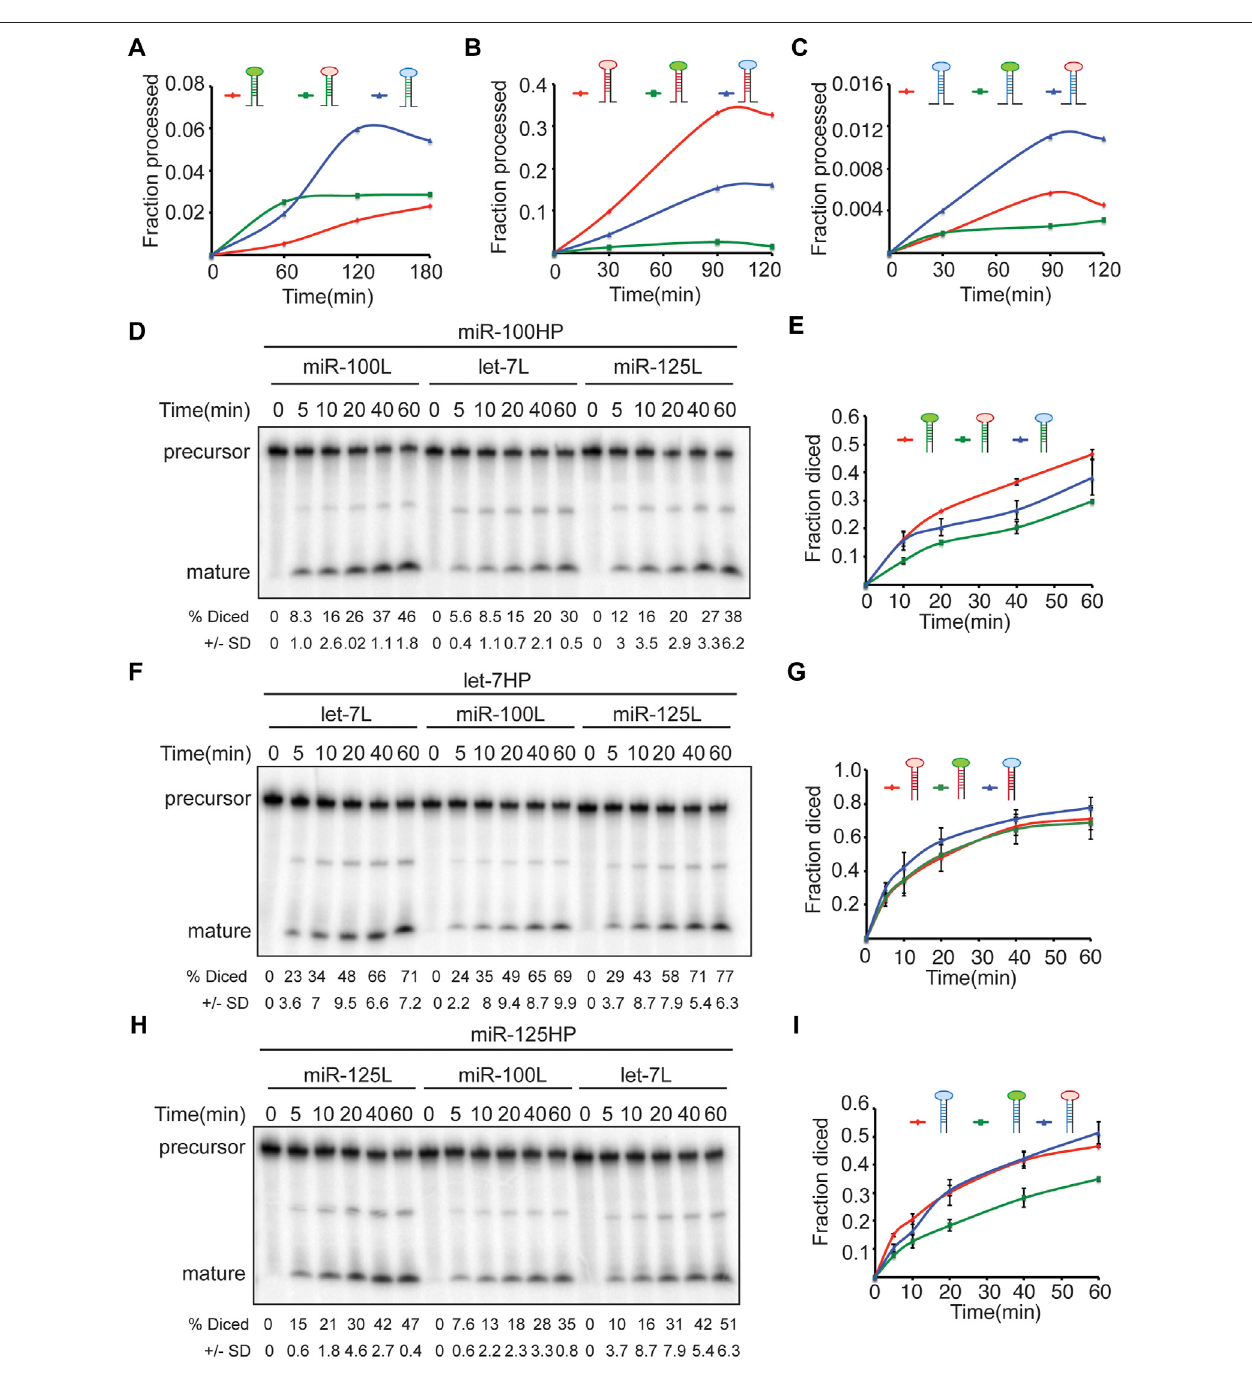
FIGURE 8 | Terminal loops determine the kinetics of Drosha and Dicer processing of let-7-C miRNAs. (A – C) Chimeric and wild type transcripts were subjected to Drosha cleavage, and the fraction of processed pre-miRNA was calculated as the ratio of pre/pre+pri. Line graph depicting kinetics of processing of wild type (red line) and chimeric pri-miR-100 (blue and green) (A) , wild type (red line) and chimeric pri-let-7 (green and blue) (B) , and wild type (red line) and chimeric pri-miR-125 (C) . (D – I) ChimericandwildtypetranscriptsweresubjectedtoDicercleavage,andthefractionofprocessedmiRNAwascalculatedastheratioofpro/pre+pro. (D) Pre-miR- 100 was processed more ef fi ciently than pre-miR-100Hlet-7L or pre-miR100HmiR-125L. Products were resolved by gel electrophoresis on a 10% polyacrylamide gel. (E) Line graph depicting kinetics of processing of wild type (red line) and chimeric pre-miR-100 (blue and green). (F) Pre-let-7HmiR-125L is diced more ef fi ciently than pre-let-7 or pre-let-7HmiR-100L. Products were resolved by gel electrophoresis on a 10% polyacrylamide gel. (G) Wild type (red line) and chimeric pre-let-7 (green and blue). (H) Pre-miR-125 and pre-miR-125Hlet-7L are diced more ef fi ciently than pre-miR-125HmiR-100L. (I) Line graph depicting kinetics ofprocessing ofwild type (red line) and chimeric pre-miR-125 (blue and